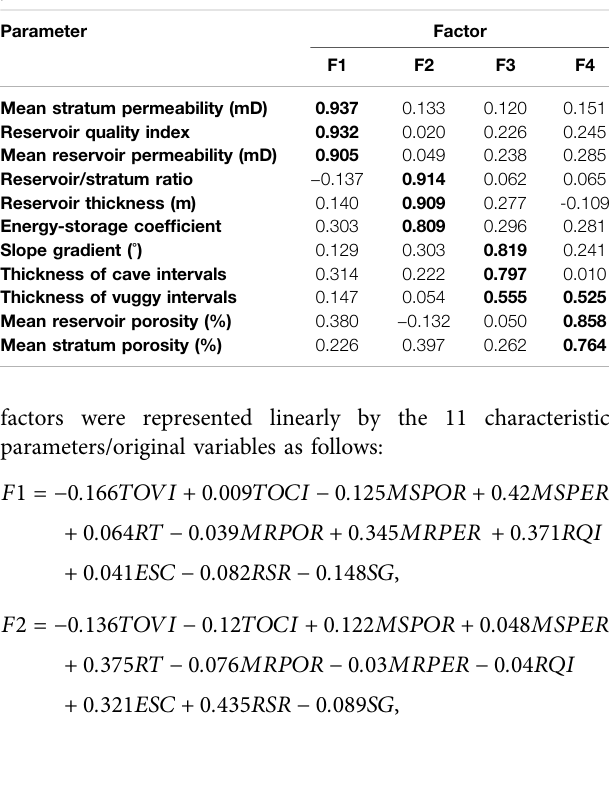
TABLE 3 | Rotated component matrix. The bold values refer to large factor loadings, which indicates great impacts of different factors on various